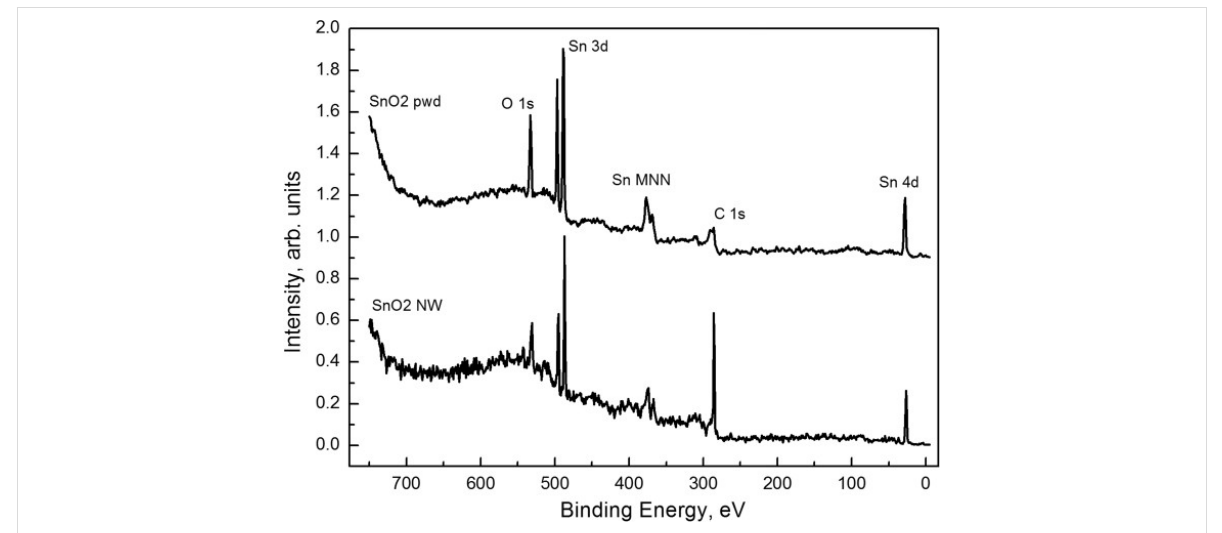
Figure 5: Photoelectron survey spectra for tin dioxide nanowires and powder samples obtained at an excitation energy of 800 eV.